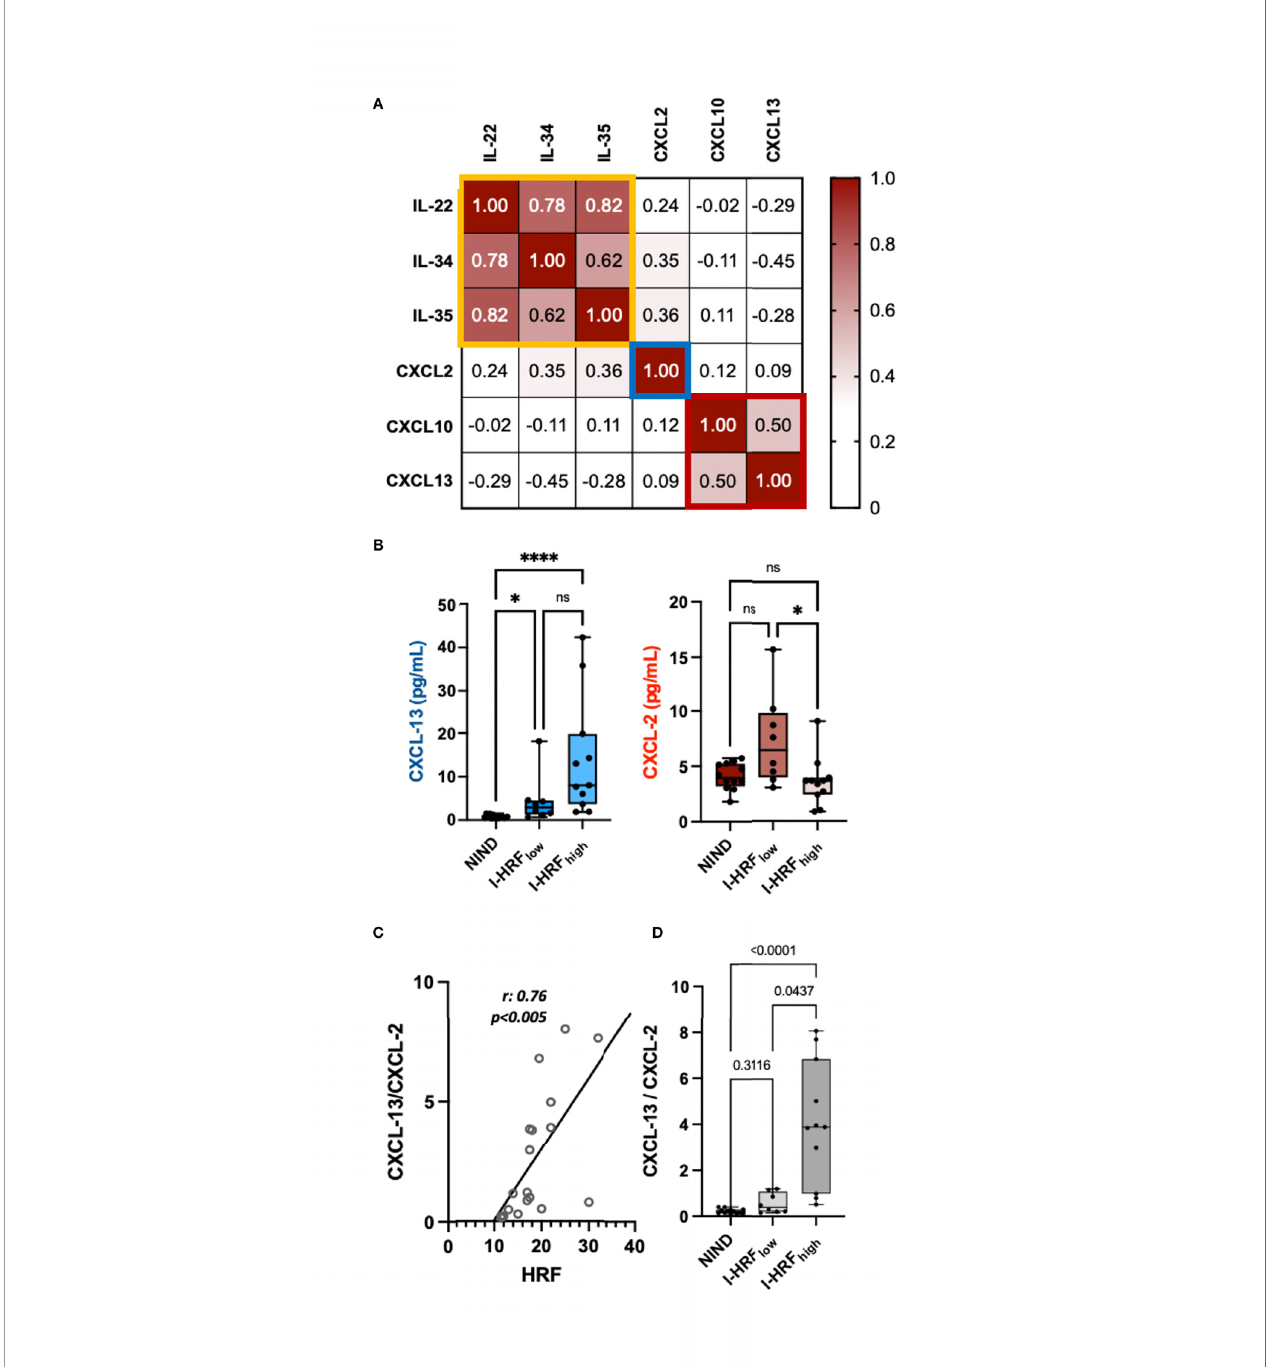
FIGURE 2 | INL HRF count associates with an imbalance between CSF concentrations of CXCL-13 and CXCL-2. (A) Correlation matrix revealed 3 clusters of cytokines, narrowed to 2 by multiple regression analysis (CXCL-13 and CXCL-2). (B) While CXCL-13 CSF concentrations progressively increased from ONIND to both I-HRF low and I-HRF high , CXCL-2 signi fi cantly decreased between RI-HRF low and I-HRF high . (C) The ratio between CXCL-13 and CXCL-2 strongly associated with HRF count in INL; (D) this ratio signi fi cantly increased in I-HRF high compared with both ONIND and I-HRF low . ONIND, other non-in fl ammatory neurological diseases; I-HRF low , RRMS patients with GCL HRF count ≤ 17.5; I-HRF high , RRMS patients with GCL HRF count > 17.5; *p < 0.05; ; **** p < 0.001. n.s., not signi fi